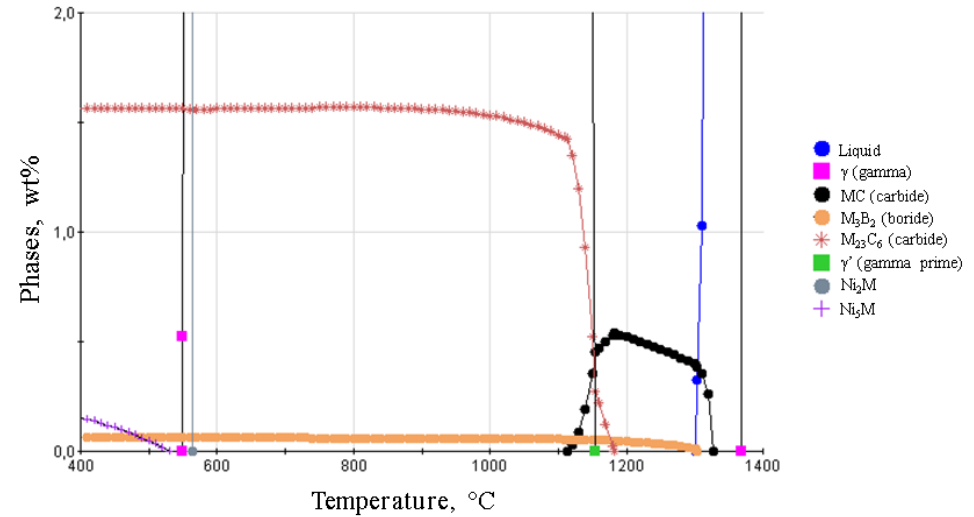
Figure 9. Percentage (in wt.%) of the minority phases vs temperature in Inconel 713C.